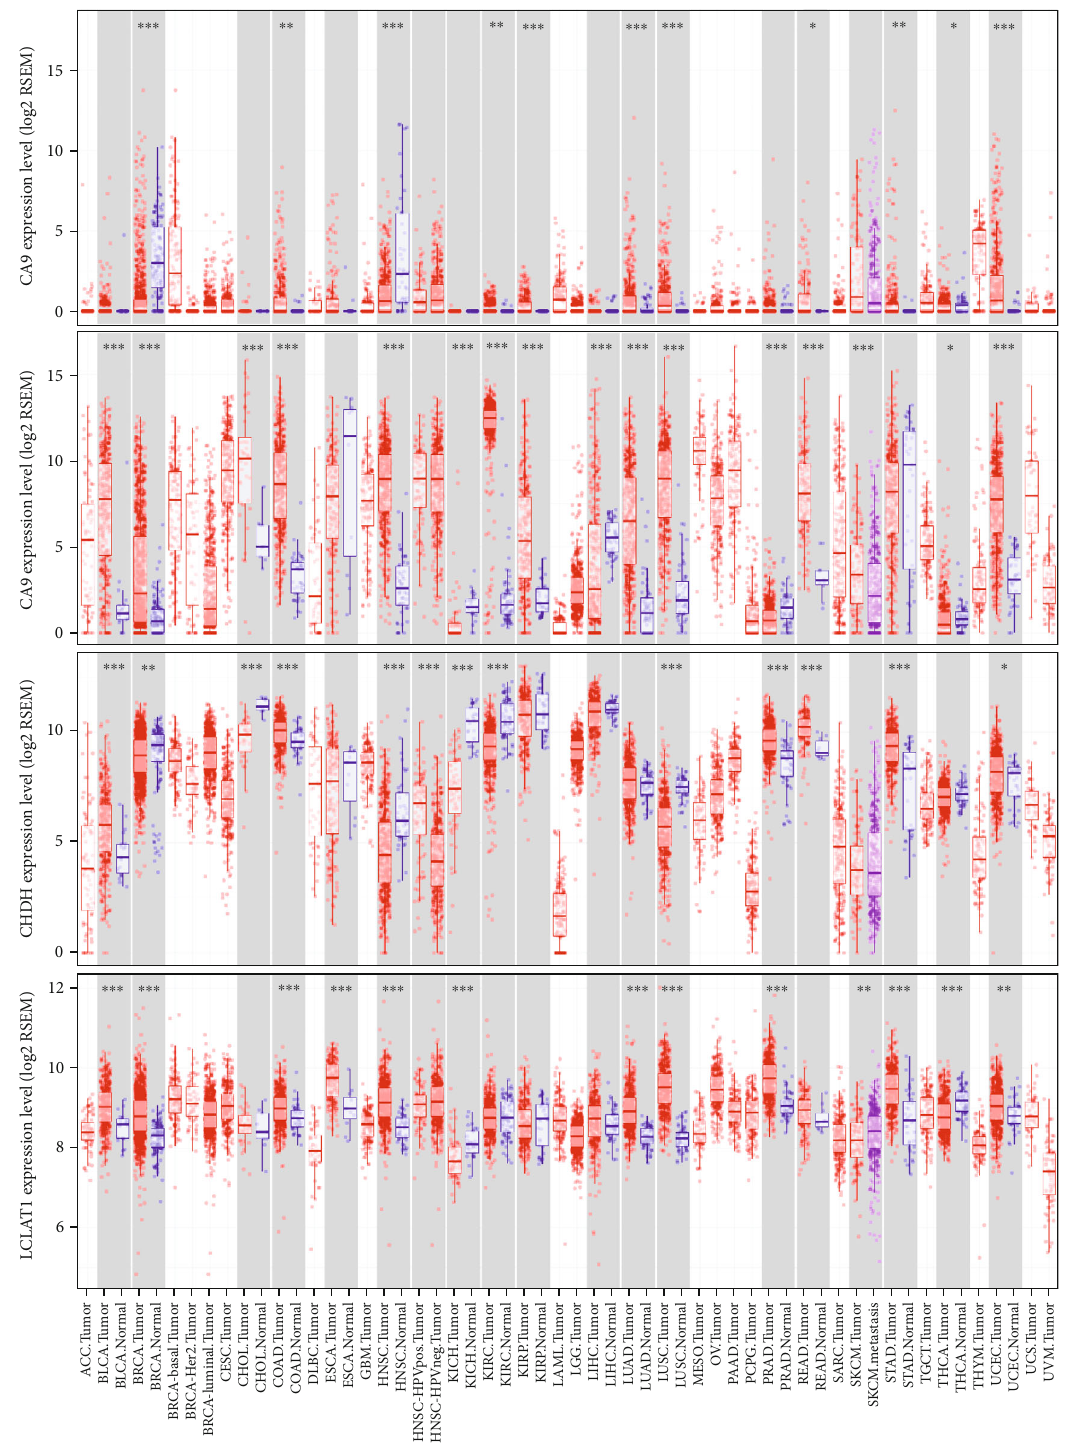
Figure 7: Di ff erential expression of CA6, CA9, LCLAT1, and CHDH between tumors and normal tissues based on TIMER